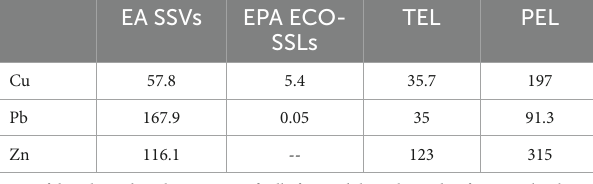
None of these limits have been set specifically for amphibians but rather for general soil quality. The EPA ECO-SSL values (United States Environmental Protection Agency, 2007) are based on bioassays of water vole and shrew (mammals), which were the most sensitive species in the guidance. For the purpose of this study, these values are taken as an absolute maximum, under the knowledge that amphibians are more sensitive than mammals. All values in